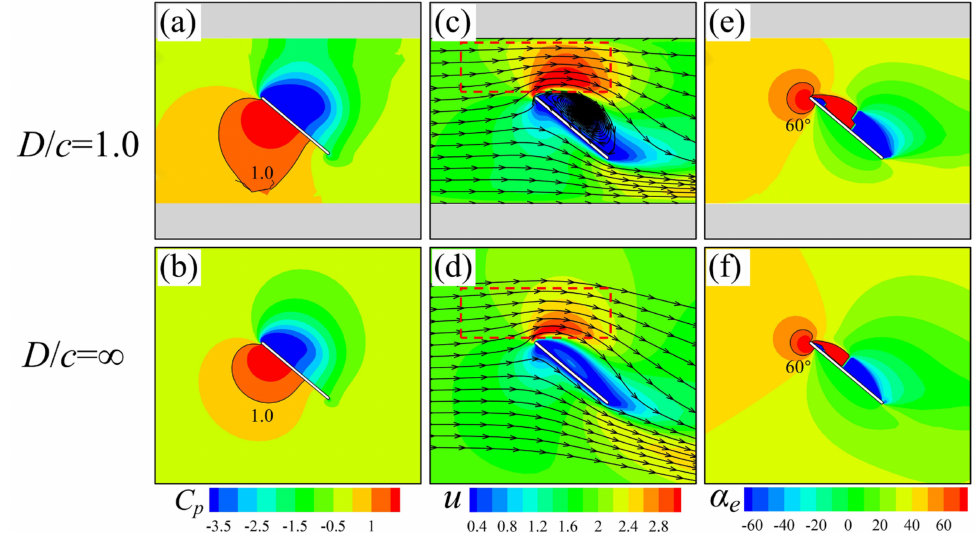
Figure 23. The pressure ( C p ) distributions ( a , b ), the streamlines and velocity ( u ) contours relative to the wing ( c , d ), and the effective angle of attack ( α e ) contours ( e , f ) at the first mid-downstroke ( τ = 0.25) and Re = 100. The first row is for D / c = 1.0, and the second row is for D / c = ∞